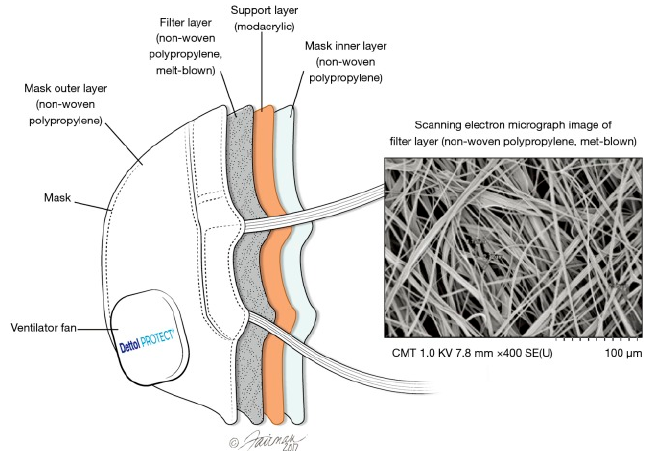
Figure 6. Schematic of different layers of N95 respirator. Reproduced with permission from reference [59]. Copyright (2018), Journal of Thoracic Disease.